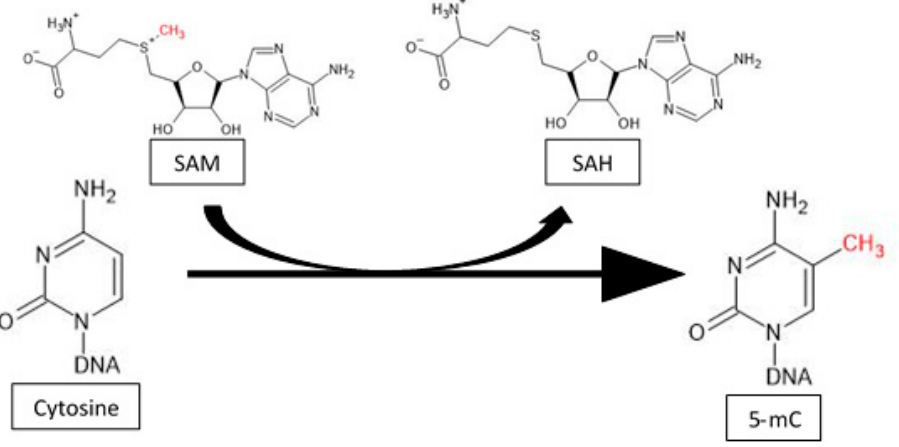
Figure 3. The mechanism of cytosine methylation. The mechanism of methylation is catalyzed by DNMTs. Those enzymes transfer a methyl group from SAM to the fifth carbon of a cytosine residue to form 5-methylcytosine (5-mC).